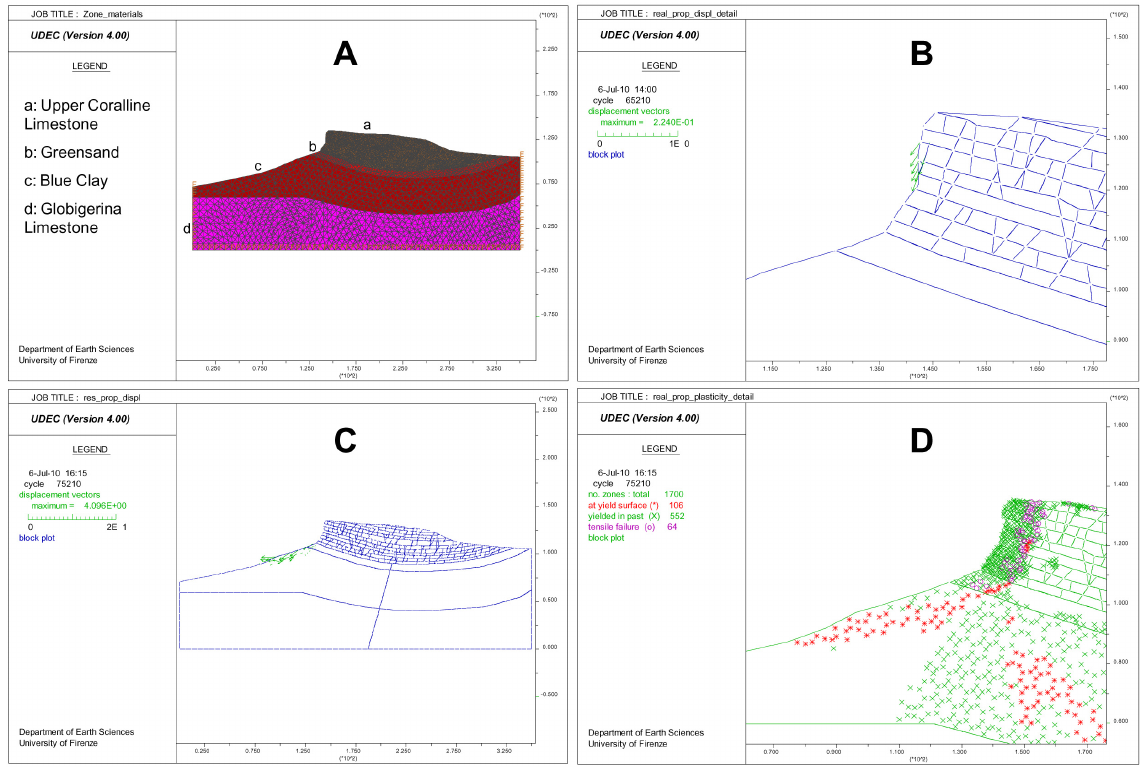
Fig. 15. Numerical modelling results. (A) : Initial model; (B) : Block displacements (third step); (C) : Displacement vectors (fourth step); (D) : Zone state (fourth